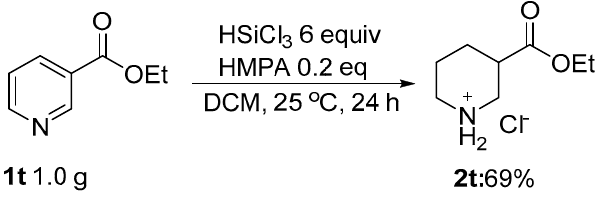
Figure 6. The gram-scale reaction of 1t.